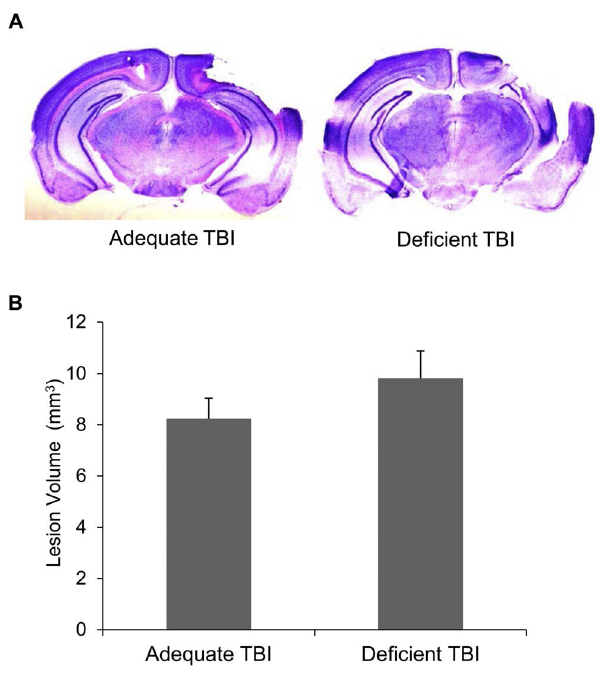
Figure 5. Depletion of DHA does not affect the volume of the lesion induced by TBI Lesion volumes of DHA depleted brains after TBI are not statistically different from those of the DHA adequate controls ( n